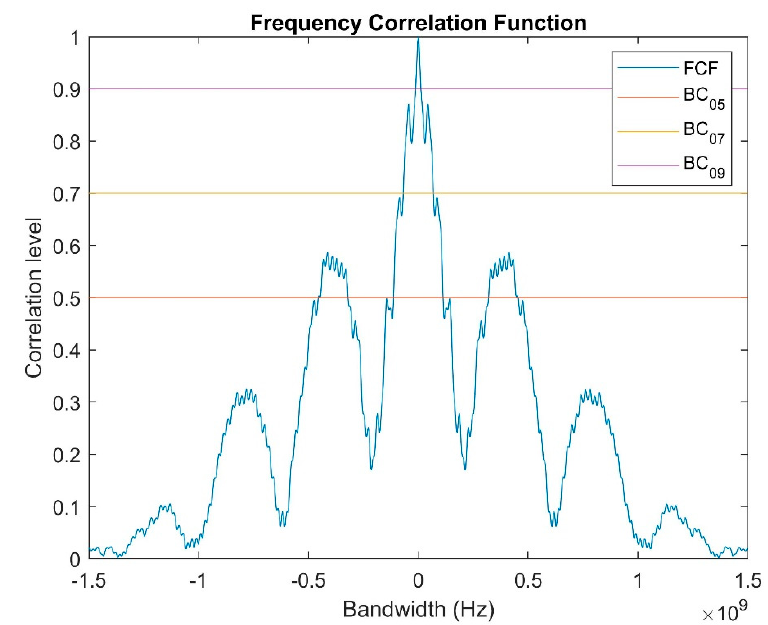
Figure 6. Frequency correlation function and estimation of coherence bandwidth at 40 GHz in the auditorium.